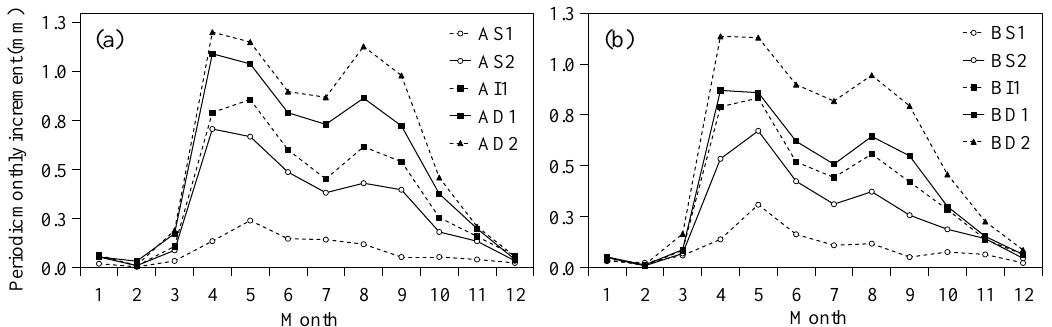
Figure 3. Average month radial growth increment of the five groups of trees at site A ( a ) and site B ( b ).